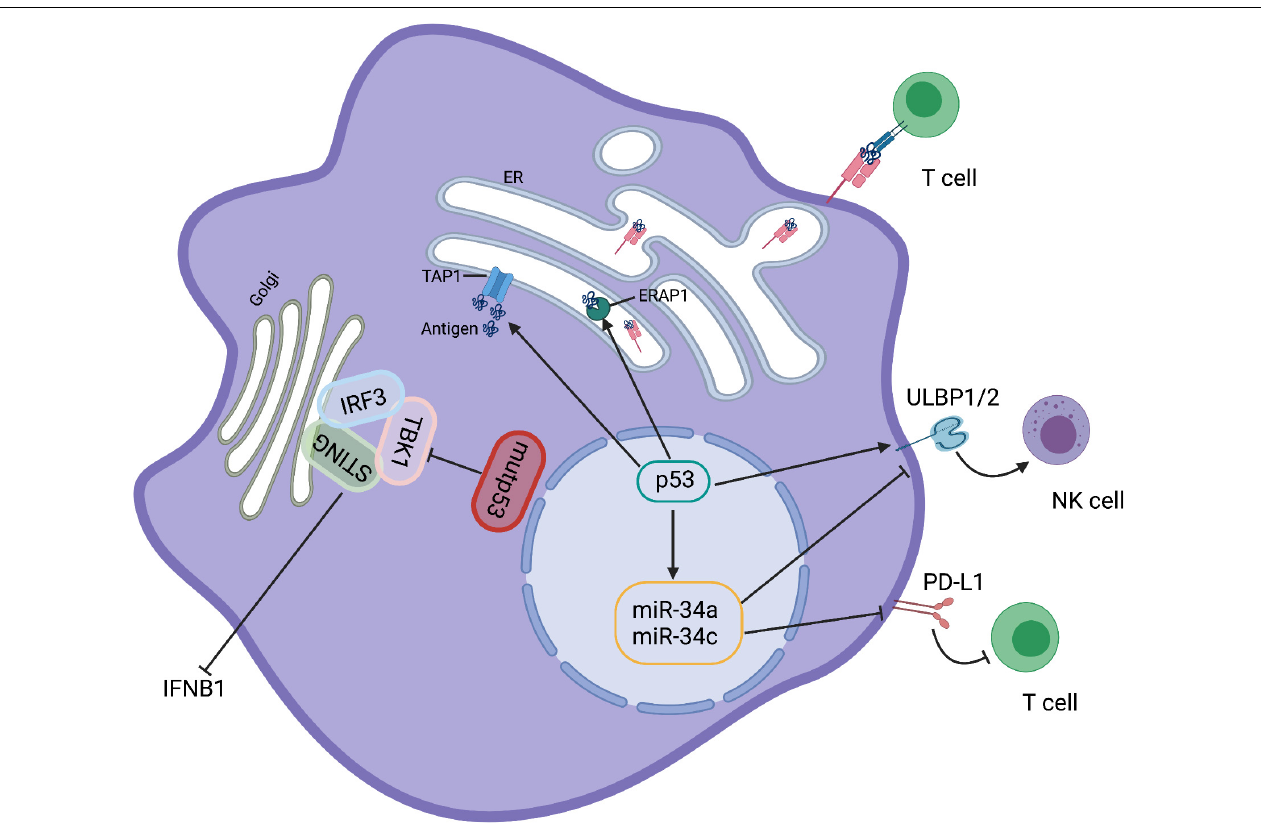
FIGURE 2 | p53 regulates immune responses. Mutp53 binds to TBK1 preventing the formation of STING-TBK1-IRF3 trimeric complexes and rendering immune evasion. p53 upregulation ULBP1 and ULBP2, the NKG2G ligands, to enhance NK cell-mediate cytotoxicity. However, activation of p53 in melanoma cells increases the expression level of miR34, a ULBP2 inhibitor that reduces the recognition of tumor cells by NK cells. Moreover, p53 and miR-34a can cooperate to regulate tumor immune evasion via PD-L1. In addition, activation of p53 is able to promote the transport and expression of MHC-I by upregulating TAP1 and ERAP1.